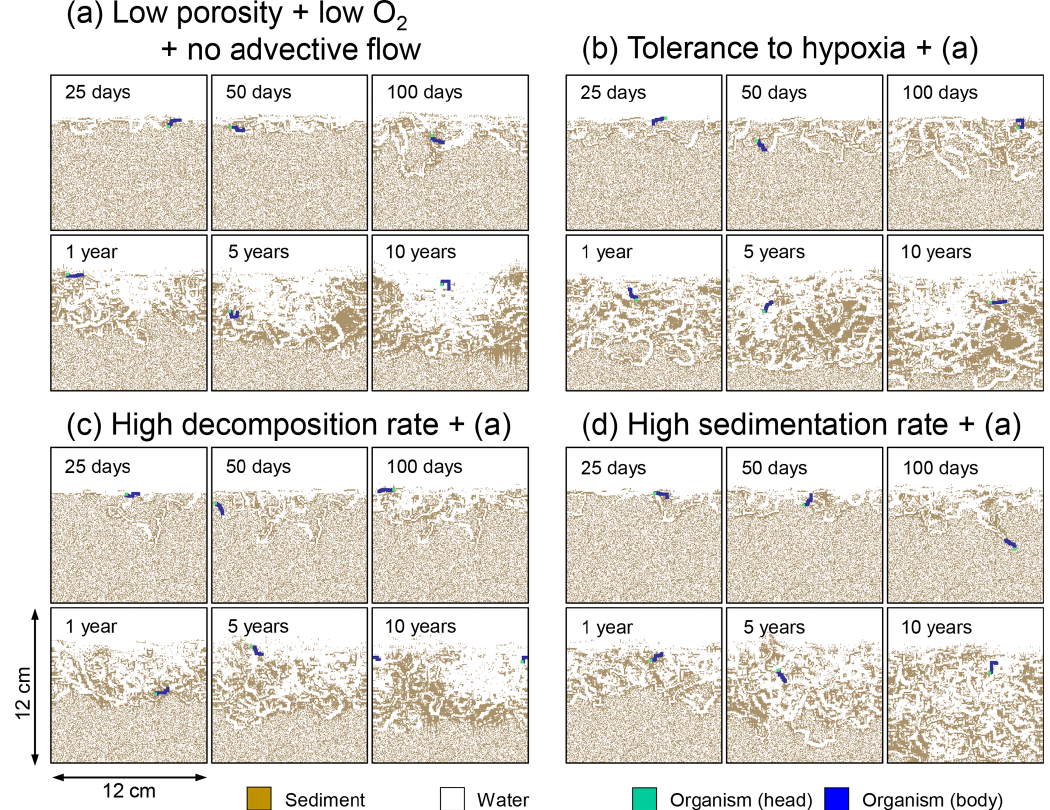
Figure 14. Time evolution of burrow geometry obtained from 10-year simulations with eLABS. See Sect. 3.3 and caption of Fig. 12 for the details of simulations (a–d) . Shown are burrow geometries at 25, 50, and 100 model days and 1, 5, and 10 model years from the start of the